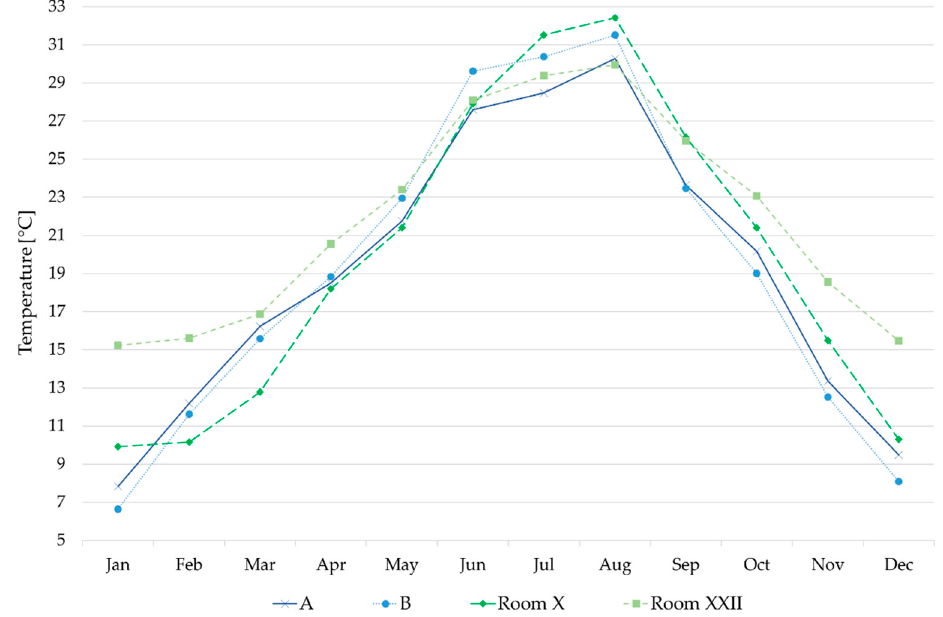
Figure 26. Trend of average indoor monthly temperature (T) measured in the analyzed zones of Vasari Corridor and La Specola museum.